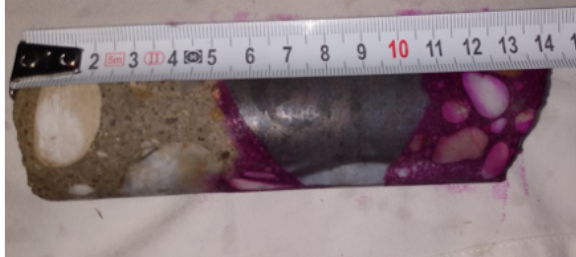
Figure 7. The carbonation depth of concrete at the places where this render was missing - sample selected from measurements performed in 2019 (Bridge in Ri- mavská Sobota).